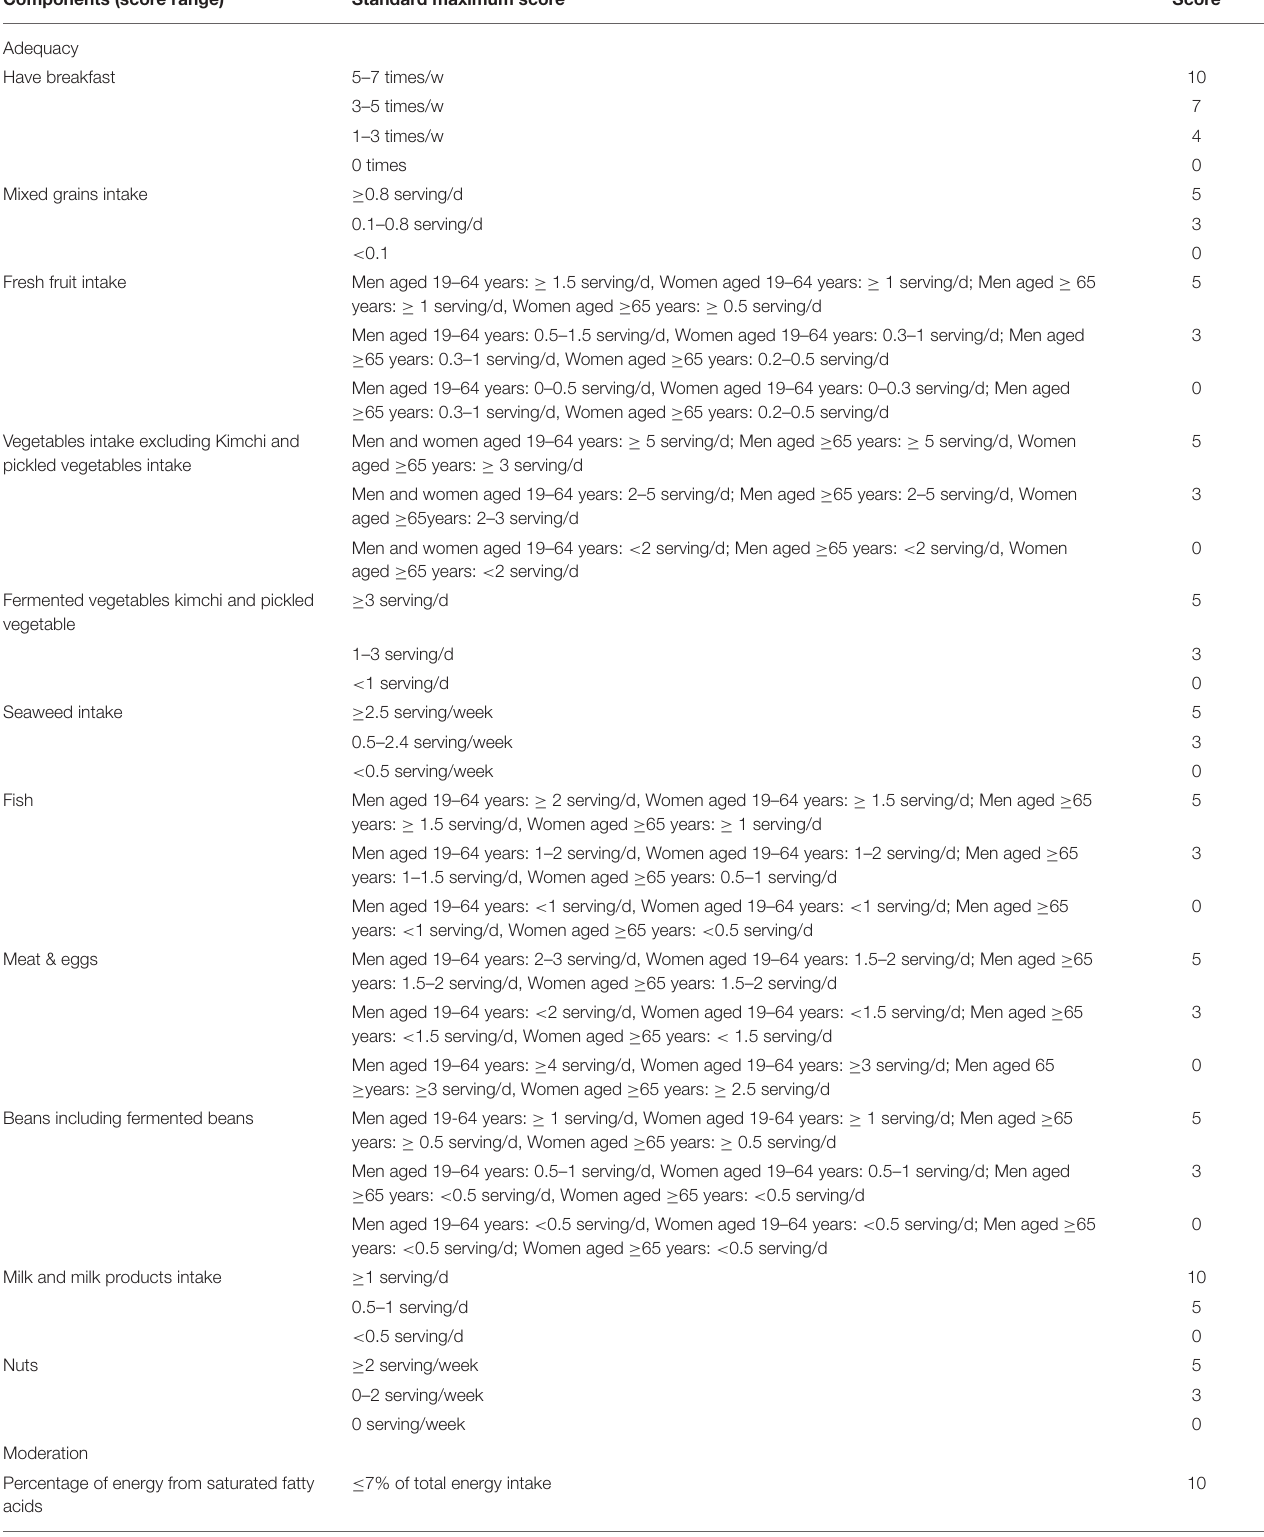
TABLE 1 | The classification of each item in modified Korean health eating index. Components (score